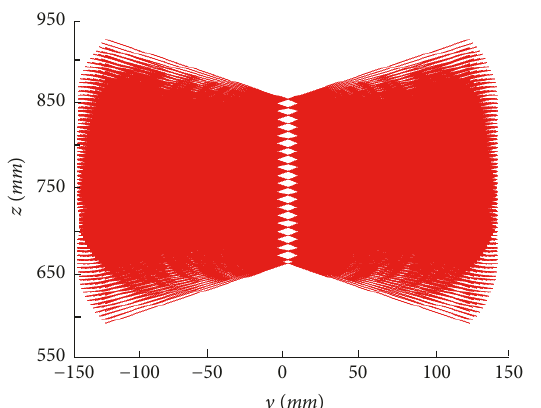
Figure 10: The workspace of the mechanism in y - z.